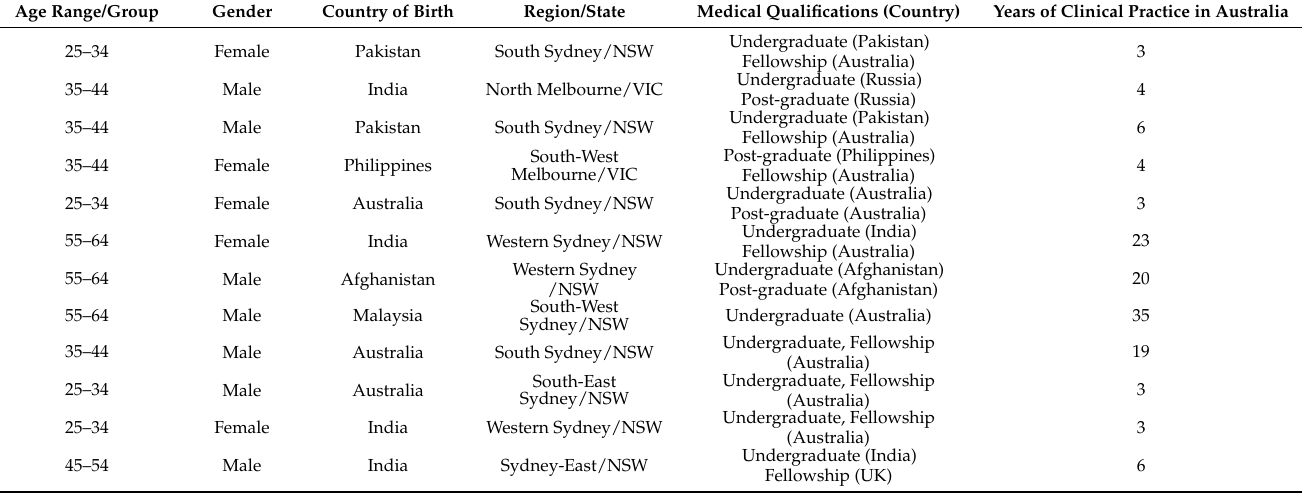
Table 1. Demographics of